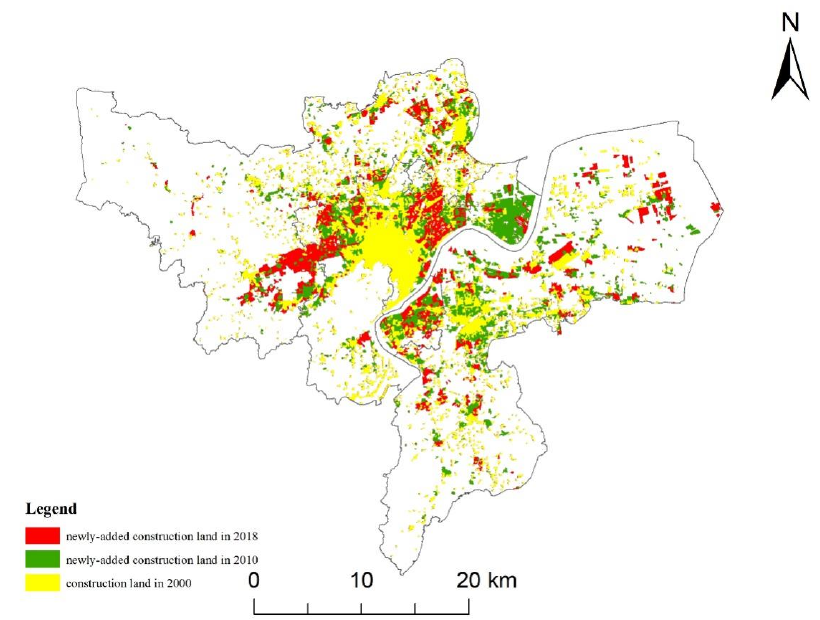
Figure 4. Spatiotemporal changes in construction land in 2000, 2010, and 2018.